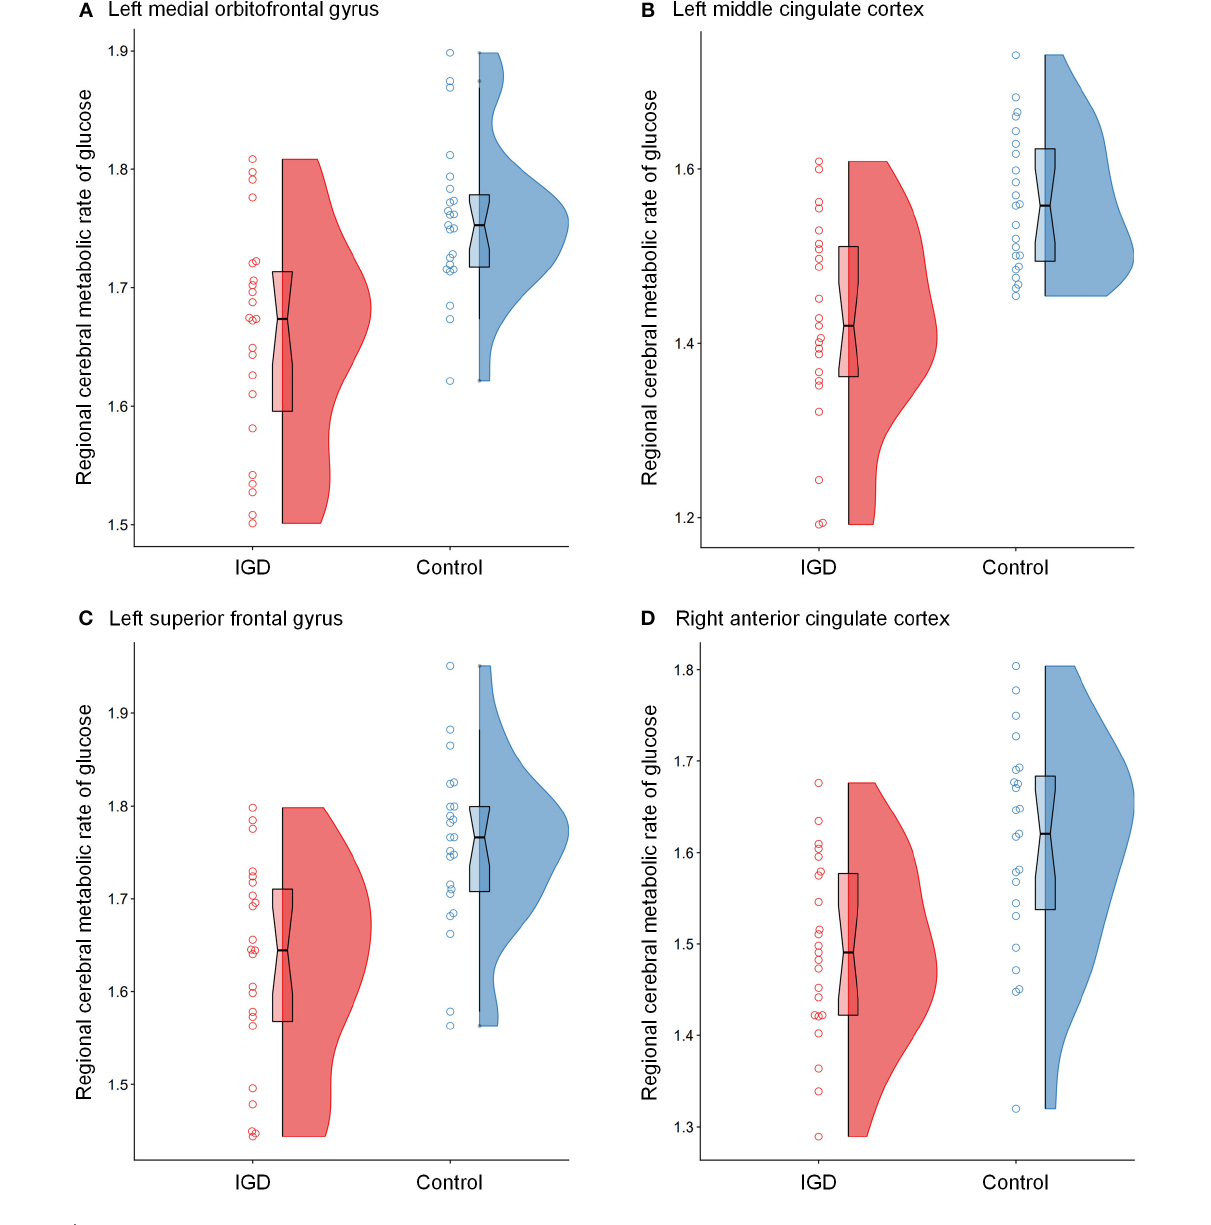
FIGURE 2 | Raincloud plots for regional cerebral metabolic rate of glucose (rCMRglu) in the (A) left medial orbitofrontal gyrus, (B) left middle cingulate cortex, (C) left superior frontal gyrus, and (D) right anterior cingulate cortex clusters with significant group differences between Internet gaming disorder (IGD) and controls. The dots represent each individual’s rCMRglu. The boxplots are overlaid on the split-half violin plots of the distribution. The detailed cluster information is listed in Table 2